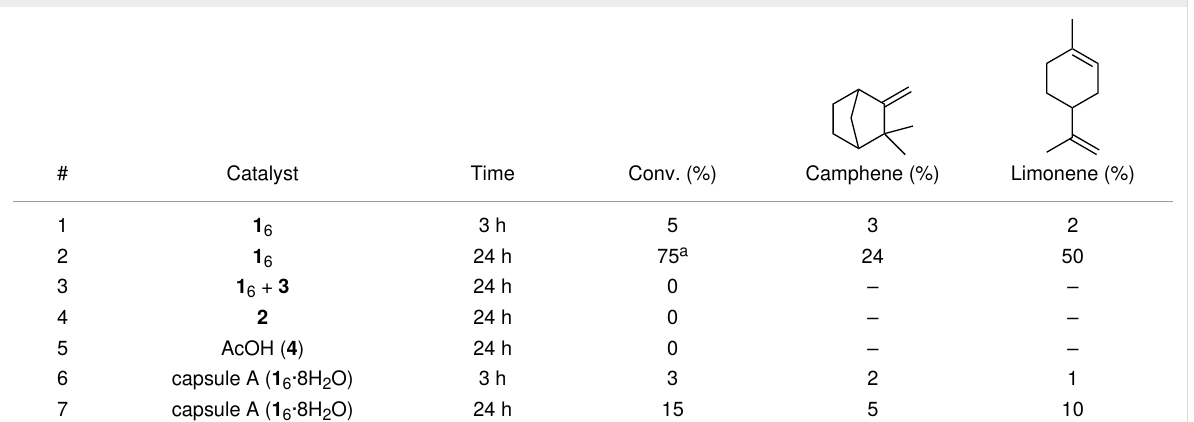
Table 3: Product distribution for the isomerization reaction of α -pinene at 60